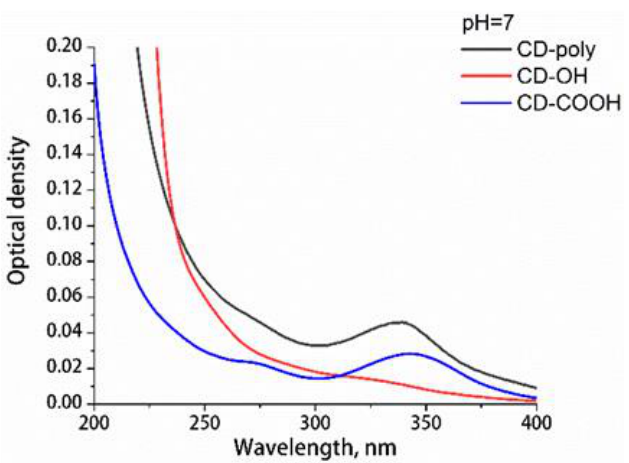
Figure 3. Optical extinction spectra of aqueous solutions for the studied CDs. pH = 7.